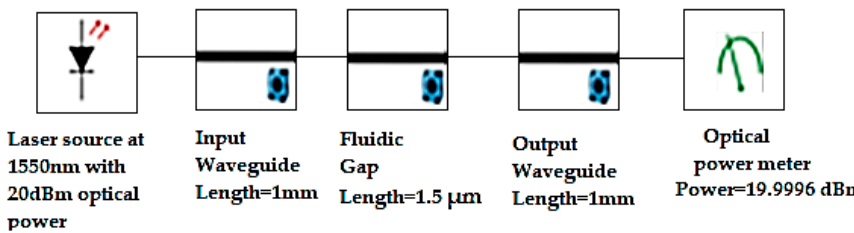
Figure 12. Optical power measurement using Interconnect.